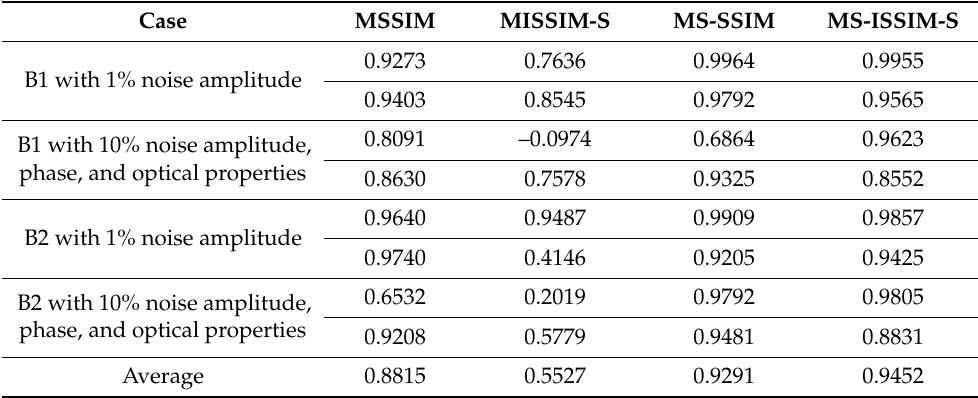
Table 3. Correlation by providing the average score using Spearman’s rank between MOS and four types of